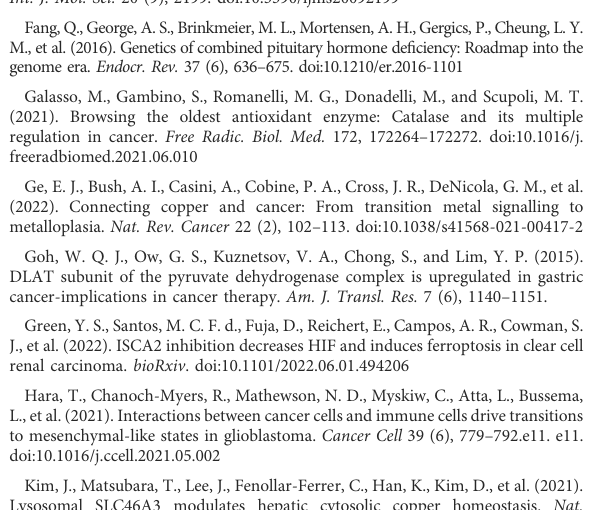
SUPPLEMENTARY FIGURE S2 Boxplot showingof CRGs expression inpaired samples extracted fromall TCGA HNSC samples. SUPPLEMENTARY FIGURE S3 Heat map of CNVs in HNSC. (A,B) Heat map of CNV in TCGA-1st (A) and TCGA-2nd (B) cohorts. SUPPLEMENTARY FIGURE S4 Effects of ISCA2 on HNSC progression in the validation cohort. (A – C) Kaplan-Meier curve showing the association of ISCA2 with OS (A) , PFI (B) , and DSS (C) over 5 years in TCGA-2nd cohort. (D,E) Kaplan-Meier curveshowing theassociationofISCA2 with OS (D) and progression-free survival (E) over 5 years in the GSE65858 cohort. SUPPLEMENTARY TABLE S1 Clinical features of HNSC patients in current study. SUPPLEMENTARY TABLE S2 Cuproptosis-related gene list was analyzed in current study. SUPPLEMENTARY TABLE S3 CRPs list obtained from the STRING